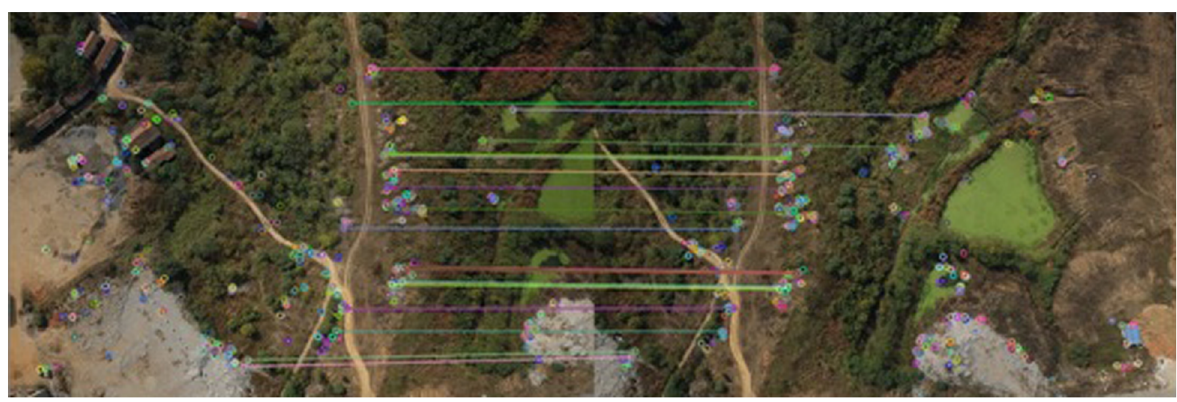
Fig. 36 Feature detection and feature point screening